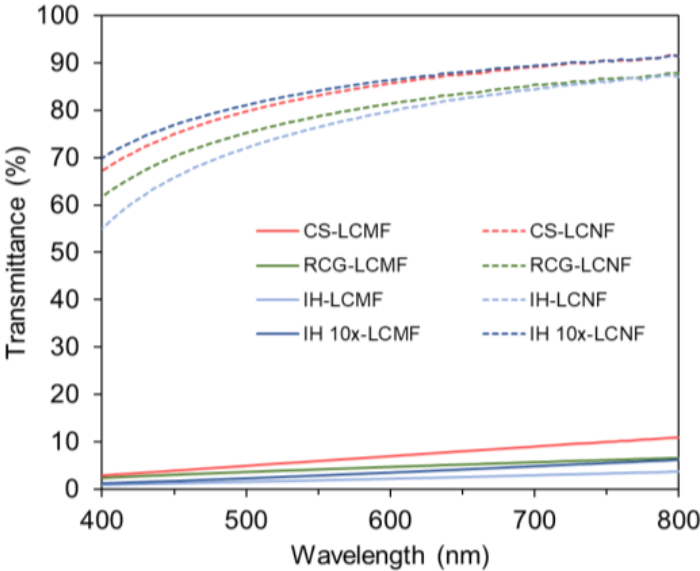
Figure 3. Optical transmittance spectra of different lignocellulosic nanofibers suspensions.